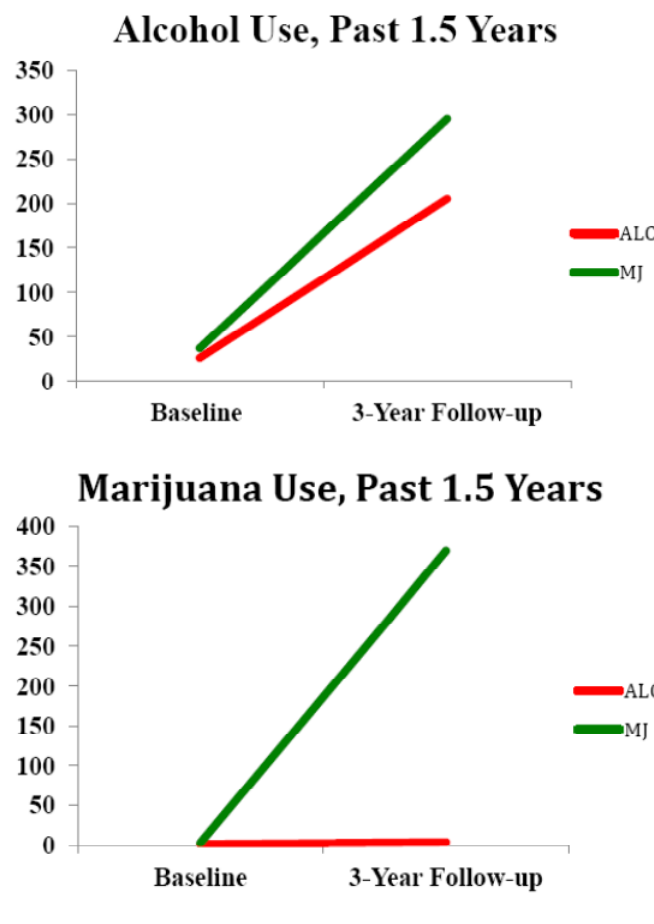
Figure 1. Participant alcohol and marijuana use at baseline and 3-year follow up ( n = 16) for substance initiators (average marijuana use episodes at baseline, ALC = 1.0; MJ = 3.6 and follow-up, ALC = 3.0; MJ =